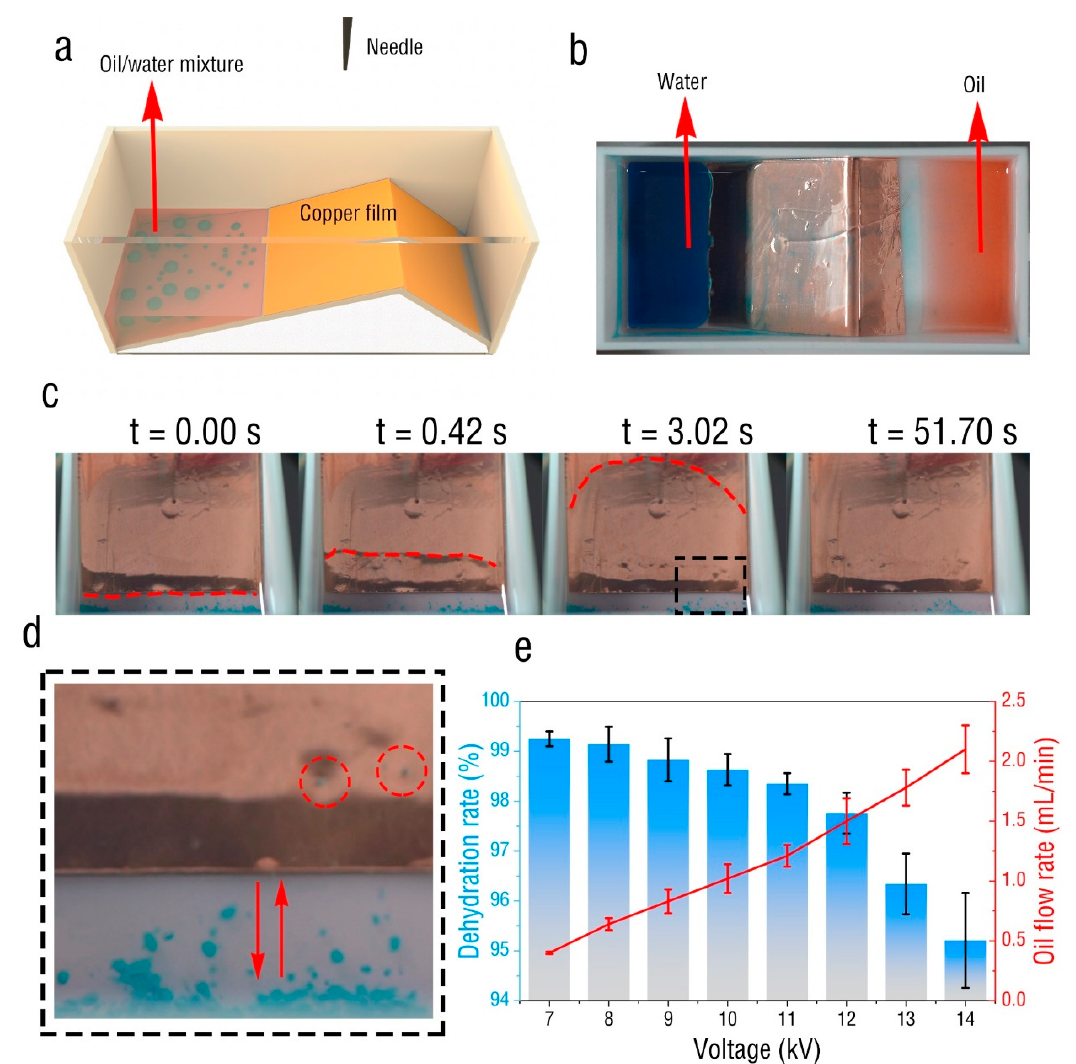
Figure 5. ( a ) Model of high-efficiency oil-water separation unit. ( b ) Image after oil-water separation under corona discharge. ( c ) The process of oil-water separation. ( d ) The oscillating motion of water droplet below. ( e ) The dehydration rate and the flow rate of the oil under different voltages.